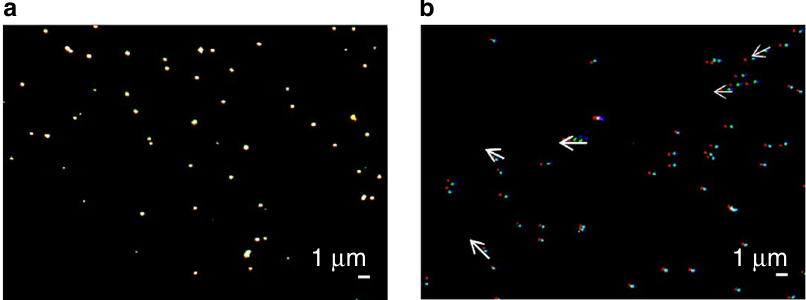
Fig. 9 Removal of non-speci fi c binding using SAW. A comparison between the movement of a speci fi cally bound and b nonspeci fi cally bound particles (biotinylated fl uorescent nanoparticles), following acoustic actuation (9.71 MHz, 220 mVpp input amplitude). The images were captured by fl uorescence microscopy. The false color coding is as follows: particles at t = 0 s are denoted in blue, at t = 2 s in green, and at t = 8 s in red. The arrows indicate the direction of the